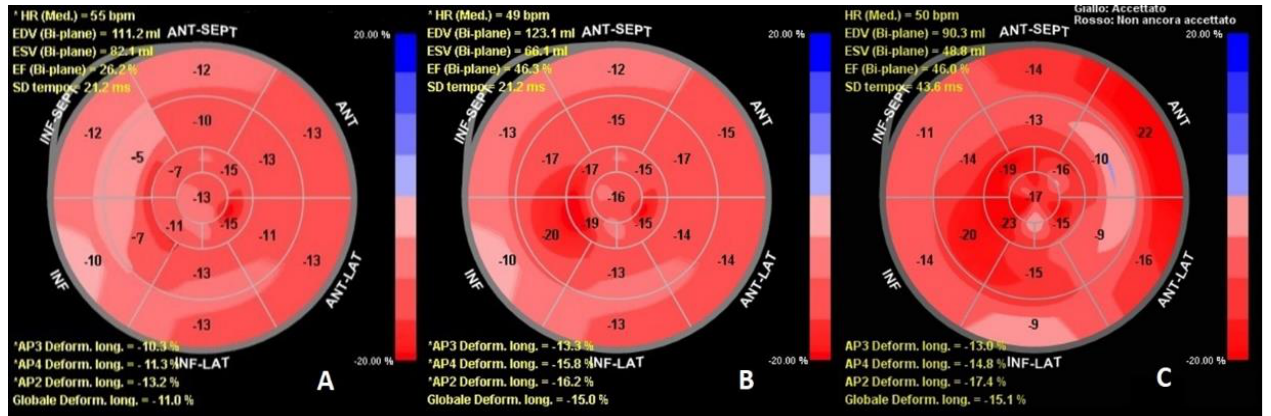
Figure 2. Left ventricular global longitudinal strain progression before and after implantation. ( A ) Left ventricular global longitudinal strain acquired the day before CCM implantation. ( B ) 30 days’ follow-up; the mid-segments of the infero-septal regions showed the most improvement from the device-induced remodeling. ( C ) 6 months follow-up; apex, basal anterior septum, and basal anterolateral wall have further improved. As can be seen in the image, end-diastolic volume (EDV) has not been changed consistently for one month. It is reduced compared with the implantation after 6 months. The end-systolic volume (ESV) reduced immediately after the procedure. This may be due to increased inotropism and lusipropism as a result of cardiac contractility modulation therapy.